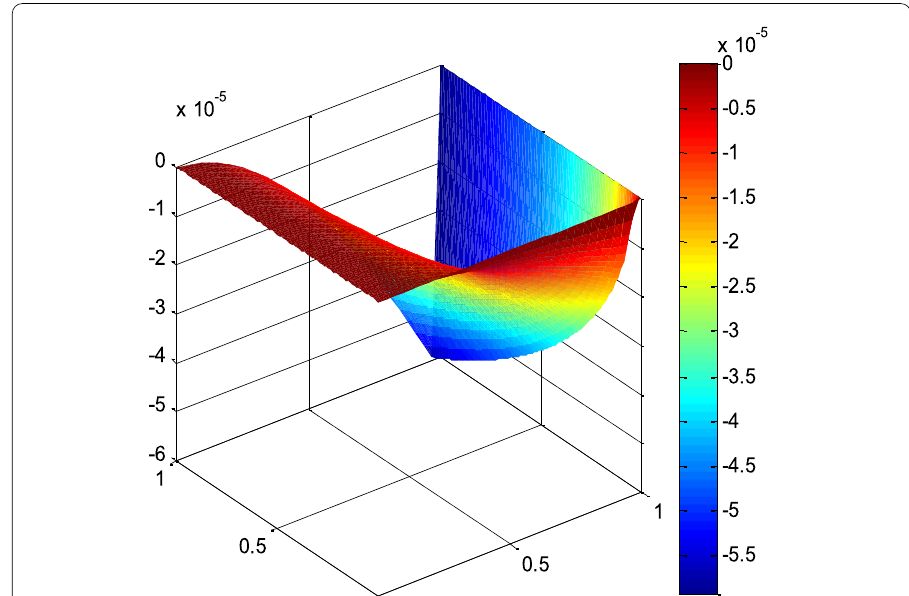
Figure 4 L1-TFPM and the exact solution